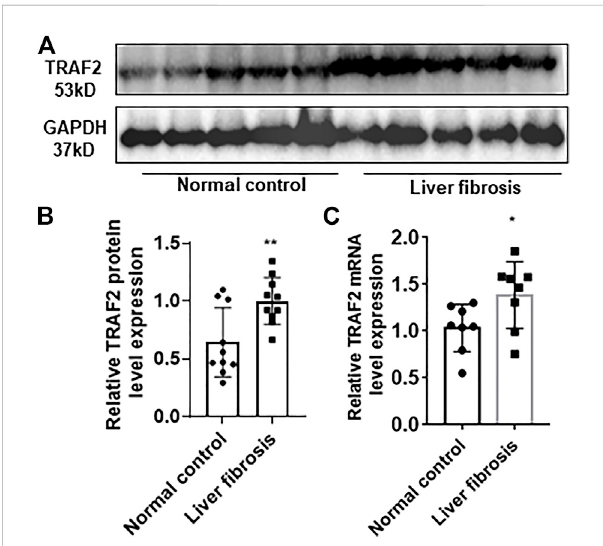
FIGURE 4 Characterization of TRAF2 expression in hepatitis B liver fi brosis. (A) Schematic representation of TRAF2 protein expression in the hepatitis B liver fi brosis and control groups by using Western blotting, n = 10. (B) Statistics of (A) plots by Image J. (C) TRAF2 mRNA expression in the hepatic fi brosis and control groups of hepatitis B